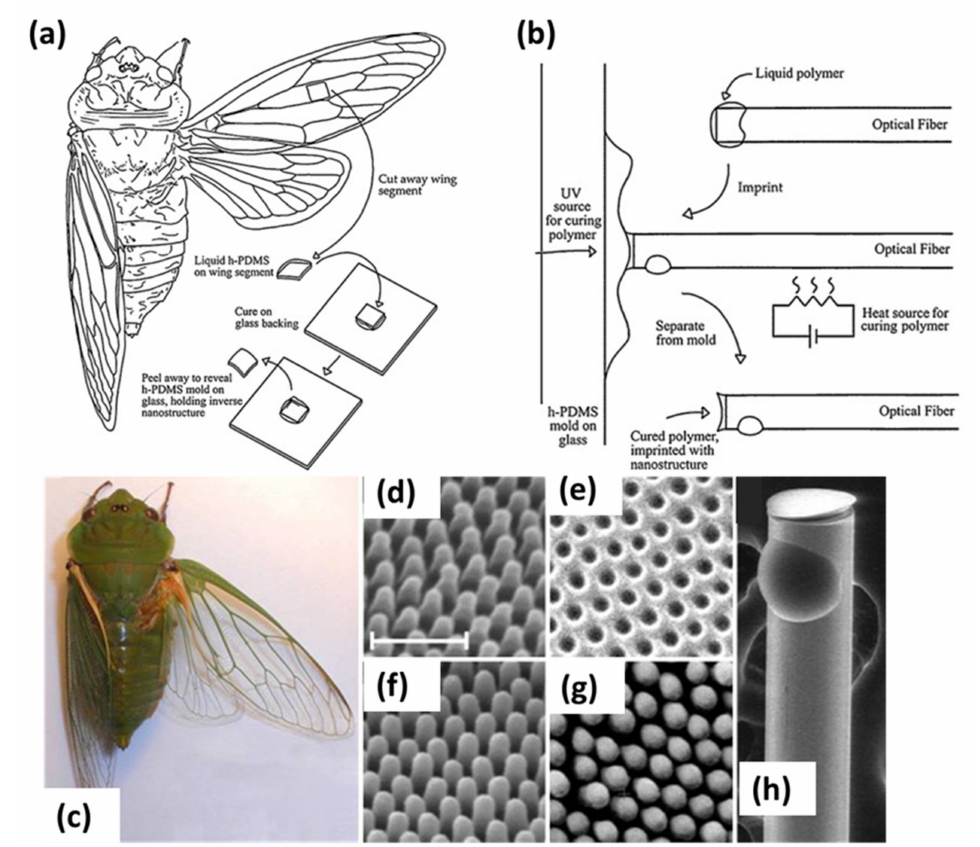
Figure 1. Illustration of ( a ) derivation of a mold from the cicada, and ( b ) application of mold to imprint the end face of an optical fiber. ( c ) Australian greengrocer cicada. SEM images of the ( d ) cicada wing nano-template, ( e ) inverse h-PDMS mold, ( f ) polymer replica on an optical fiber end face, ( g ) silver coated replica, and ( h ) macroscopic view of the imprinted optical fiber. The scale bar is 500 nm. Reprinted with permission from Ref. [47]. Copyright 2009